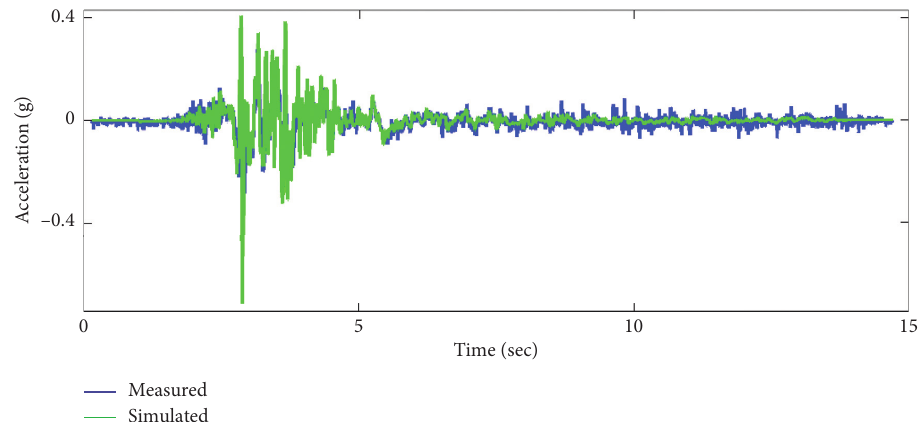
Figure 5: Time domain comparison between the measured and the simulated acceleration for the El Centro earthquake record.